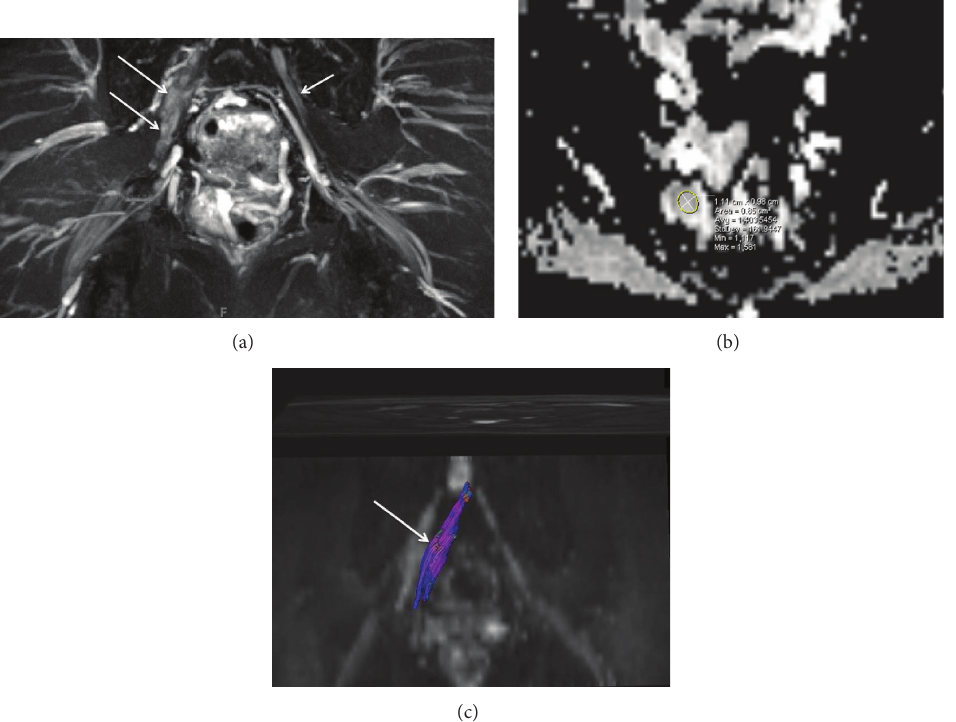
Figure 9: (a) Combined anatomic and functional MRN-MIP reconstruction from a 3D STIR SPACE sequence shows abnormal fusiform enlargement of the right S1 nerve root by a benign peripheral nerve sheath tumor (large arrows). Notice the normal appearance of the contralateral S1 nerve root (small arrow). (b) Combined anatomic and functional MRN-ADC map from single shot EPI DTI ( 𝑏 value 0, 600 s/mm 2 and20directions)sequenceshowshighADCvalue( 1.4×10 −3 mm 2 /s).(c)CombinedanatomicandfunctionalMRN-Tractography map following tensor calculation from single shot EPI DTI sequence shows nearly normal tracts (arrow) through the mass lesion in keeping with benign nature of the lesion.